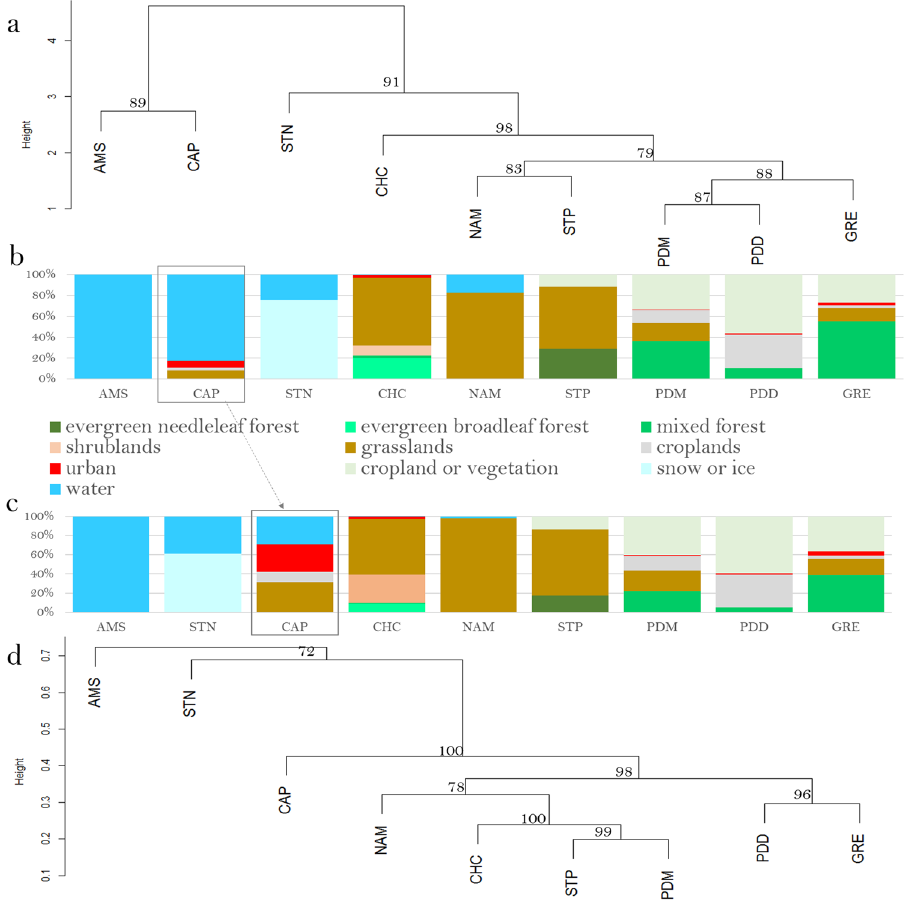
Figure 4. Distribution of the sites based on the different data sets (bacterial community structure, PM10 chemistry, landscapes, relative contributions of the different landscapes in the aerial emission of bacterial cells). ( a ) Hierarchical cluster analysis (average method) on the Euclidean distance matrix based on the PM10 chemistry. ( b ) Relative surfaces of the different landscapes surrounding the sites (perimeter of 50 km) based on the MODIS land cover approach. ( c ) Relative contributions of the different landscapes in the aerial emission of bacterial cells (based on the study of Burrows et al., (2009) 40 ). ( d ) Hierarchical cluster analysis (average method) on the Bray-Curtis dissimilarity matrix based on the bacterial community structure (genus level). Bootstrap values in percentage are indicated over each node on both cluster